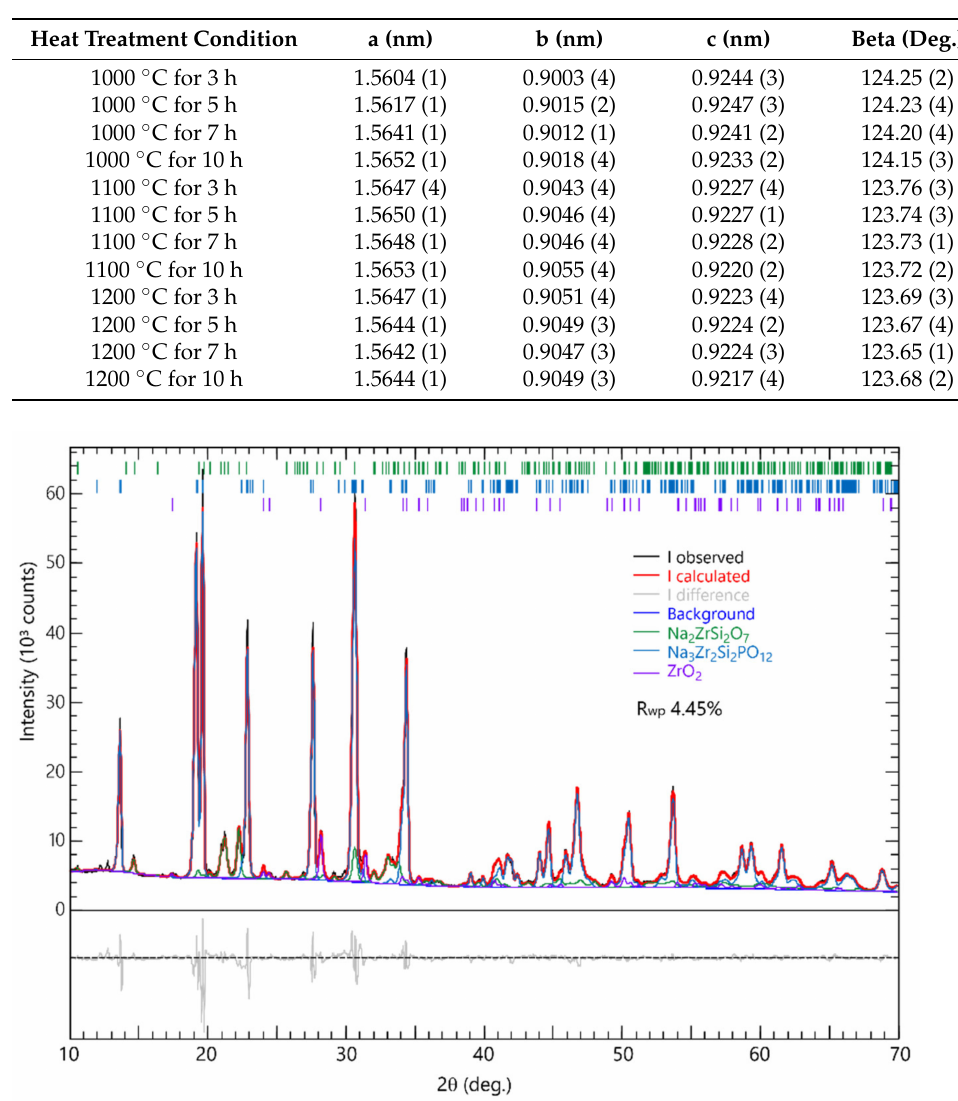
Figure 3. Refined XRD pattern of LPS-NZSP calcined at 1000 ◦ C 10